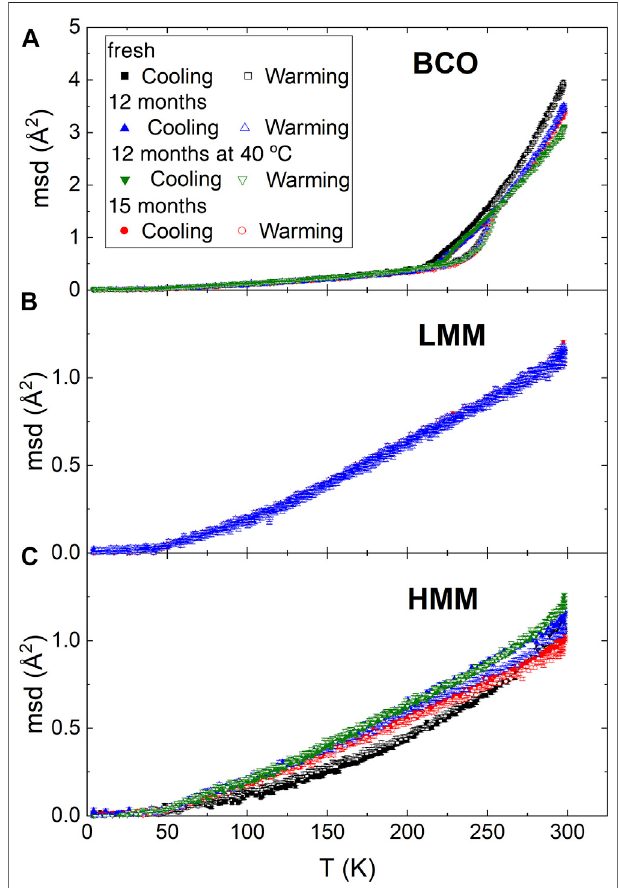
FIGURE 2 | Temperature dependence of the mean squared displacement over a timescale of ≈ 1 ns, obtained from the elastic neutron scatteringmeasurementsonHFBS.Samplesatfouragingstagesweretested as indicated in the legend of plot (A) [The legend applies to plot (B,C) as well]. Measurements for each sample were performed fi rst cooling and then heating it back again to 300 K. Plot (A,B,C) report the results for BCO, low and high molecular mass lignin fractions,